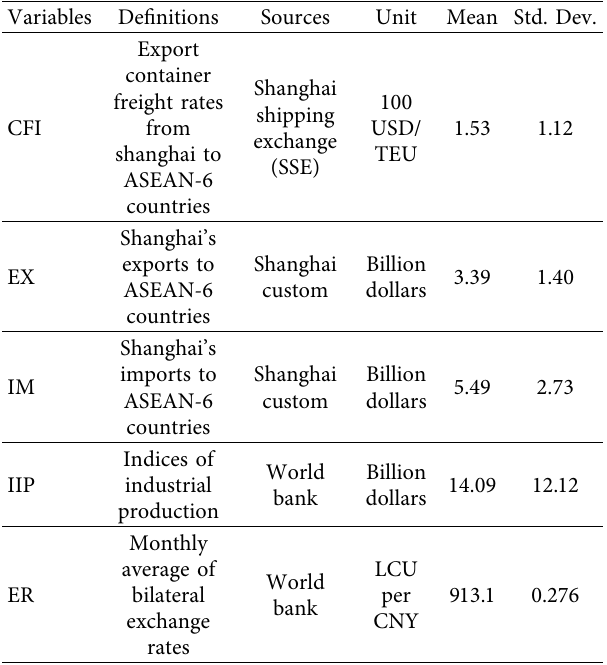
sources, and descriptive